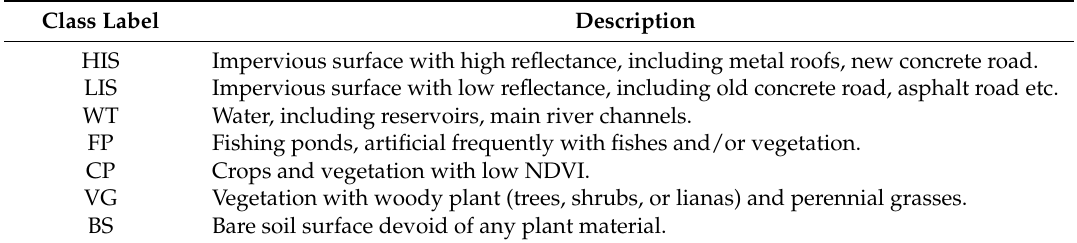
Table 1. Land cover classification scheme in this study.